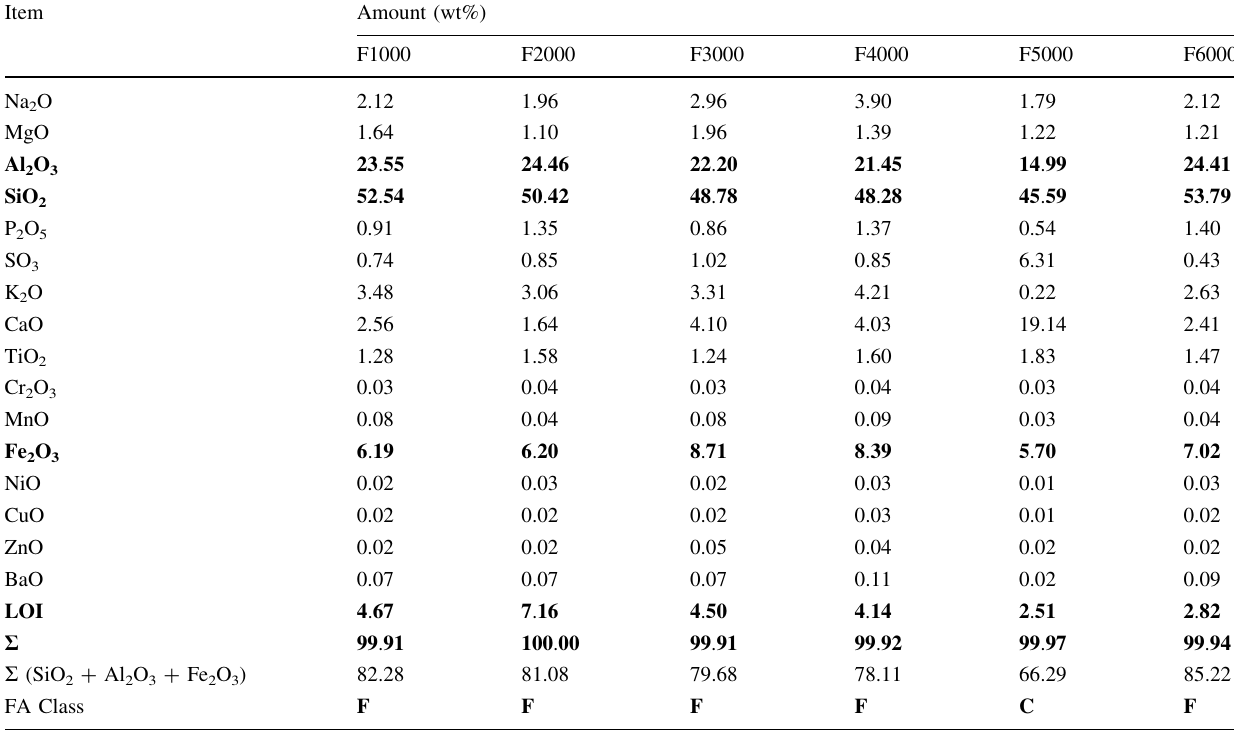
Table 3 Chemical characteristics of raw fly ash samples: F1000, F2000, F3000, F4000, F5000 and F6000 (most important components from zeolite synthesis point of are bolded and italicised)